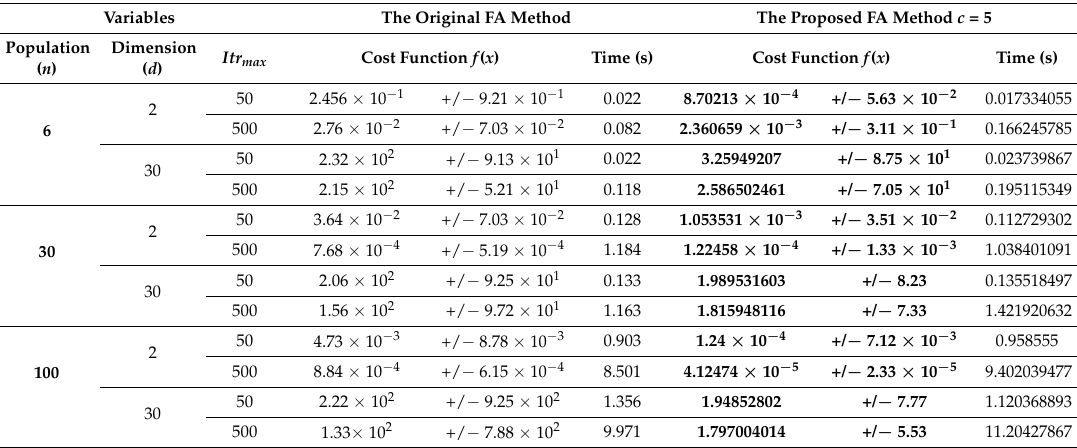
Table 2. Results of the proposed FA methods for Levy function problem.